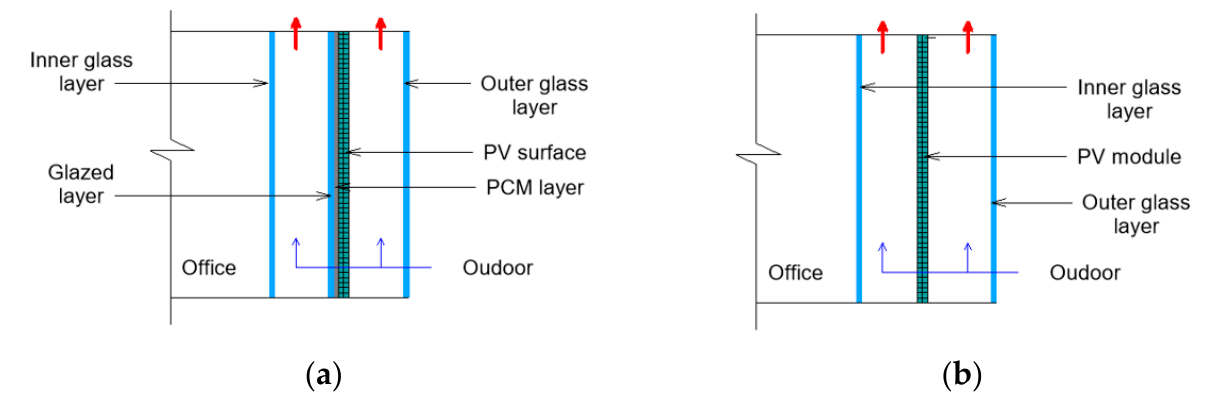
Figure 17. A scheme of glazed offices integrated with PV module ( a ) with PCM, ( b ) without PCM (data from ref. [136]) .